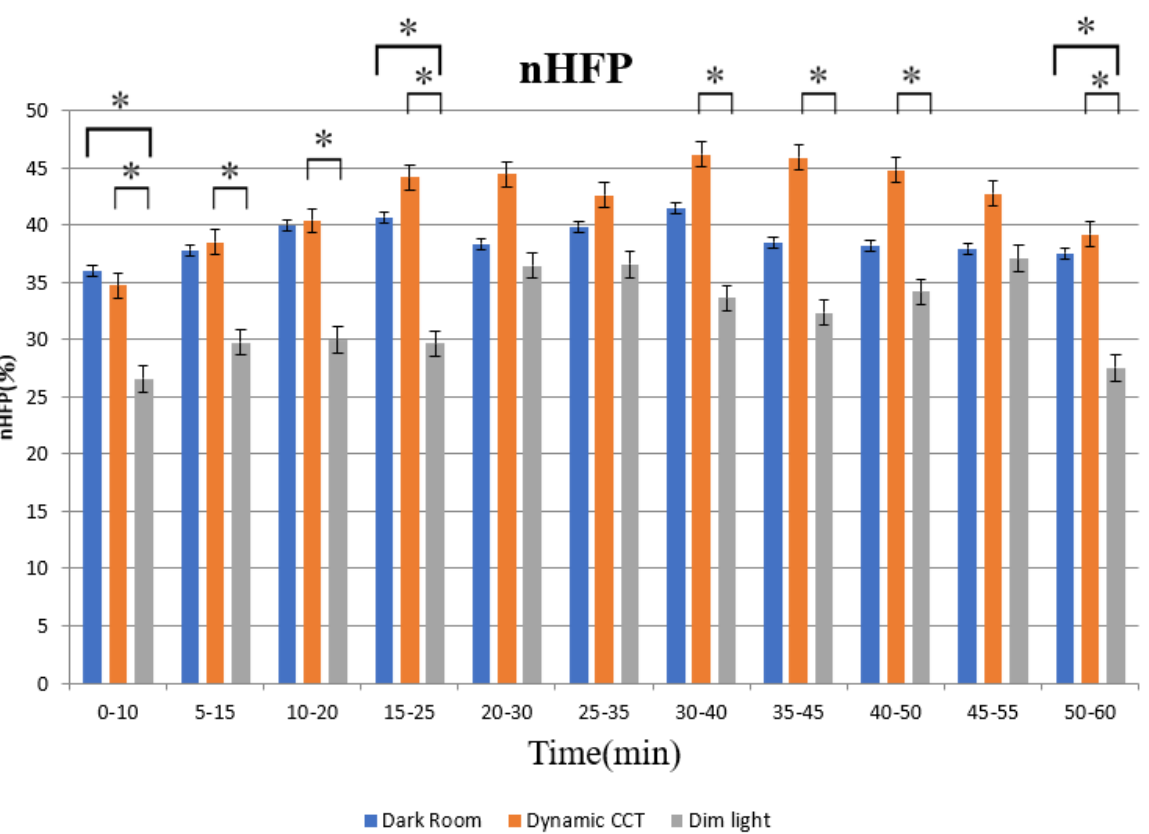
Figure 10. Dark room, Dynamic CCT, and Dim light effect comparison chart on nHFP under sleep environment. “*” is p < 0.05.